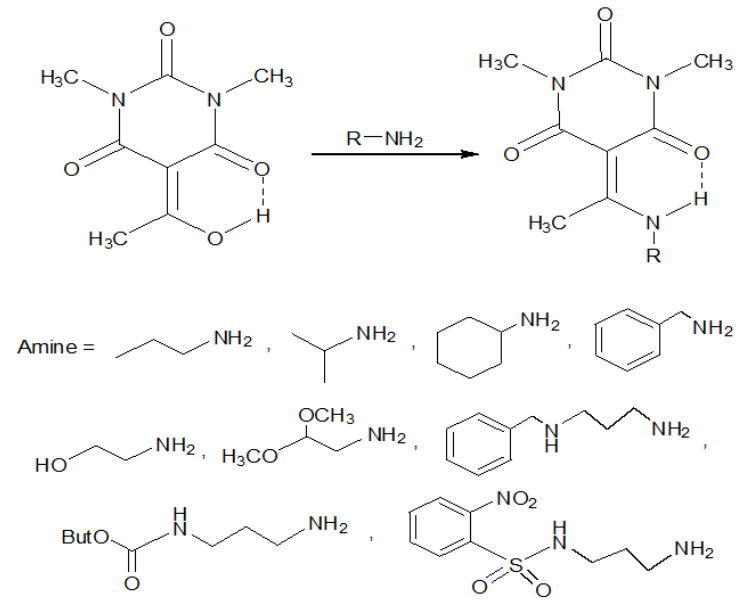
Scheme 11. Synthesized of enamine derivatives